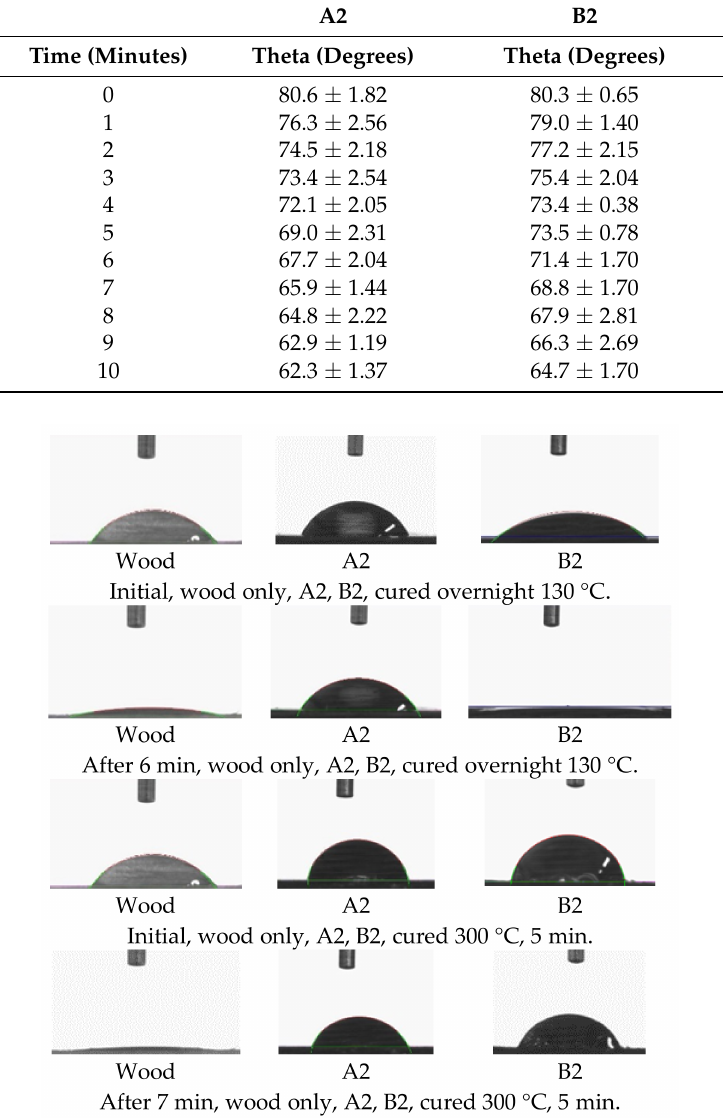
Table 5. Water contact angle on glucose (A2) and sucrose (B2) NIPU resins cured at 300 ◦ C for 3 min.